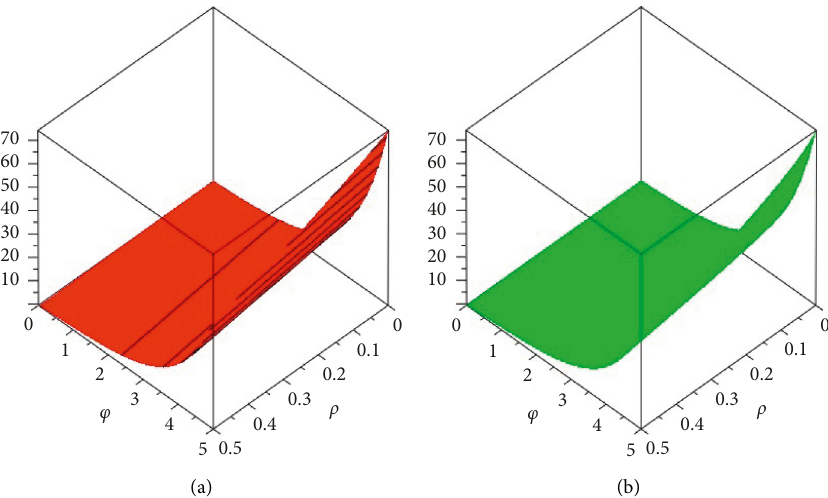
Figure 1: (a) The exact and approximate solution at δ � 1 and (b) second fractional order at δ � 0 . 8.